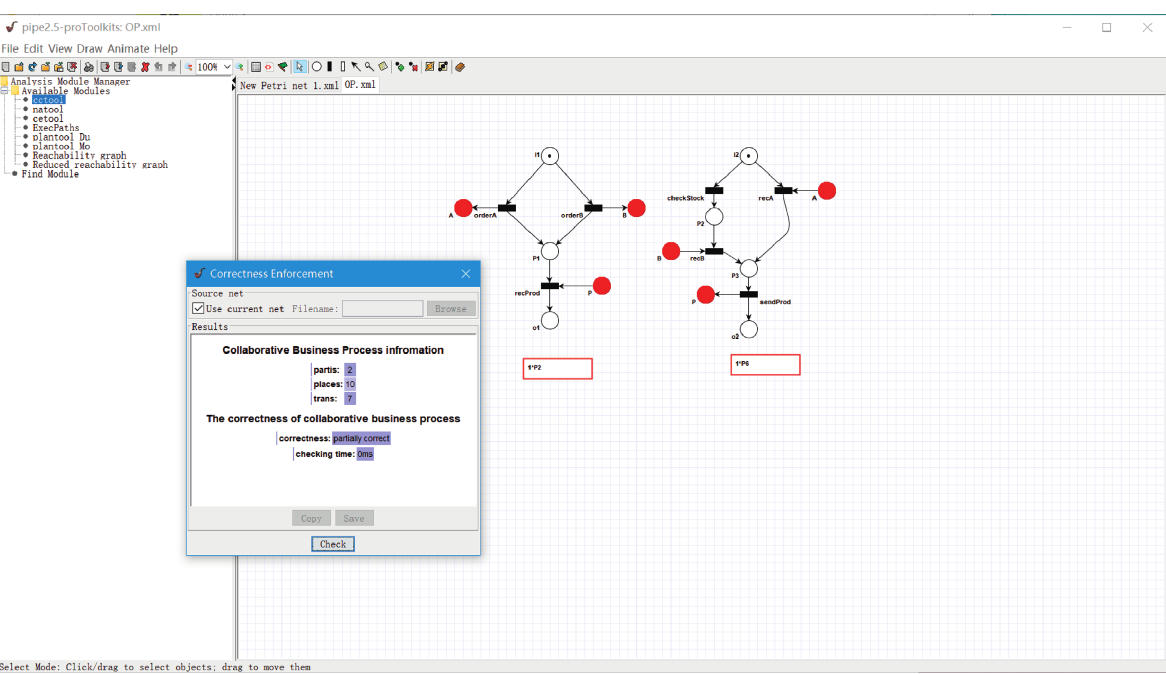
Figure 6: Screenshot of the tool